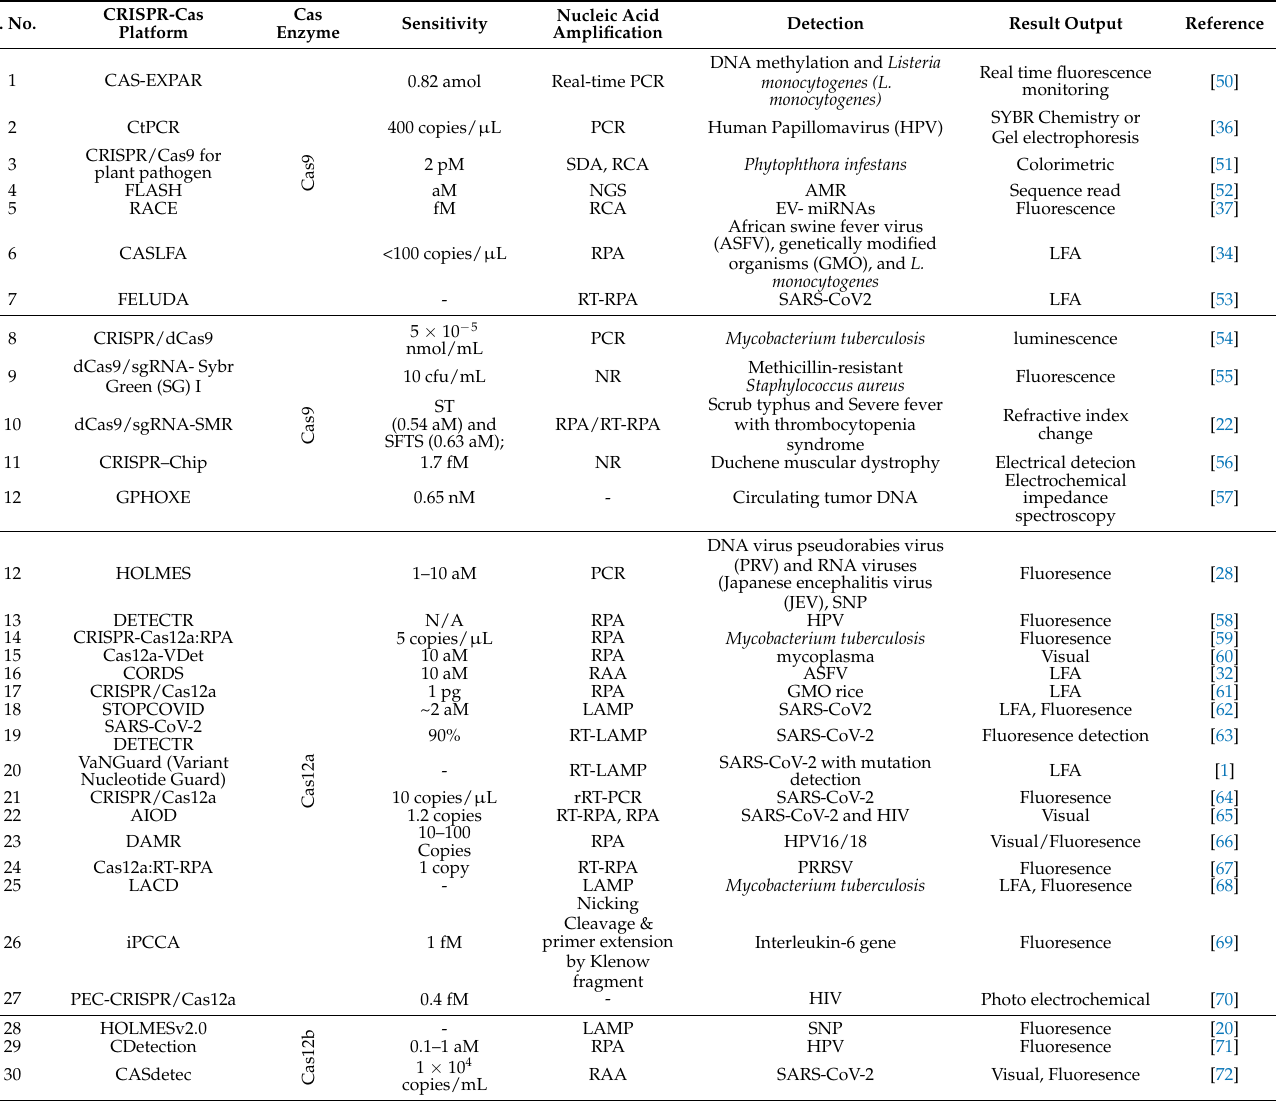
Table 1. List of CRISPR/Cas based nucleic acid detection platforms developed so far for diagnostics